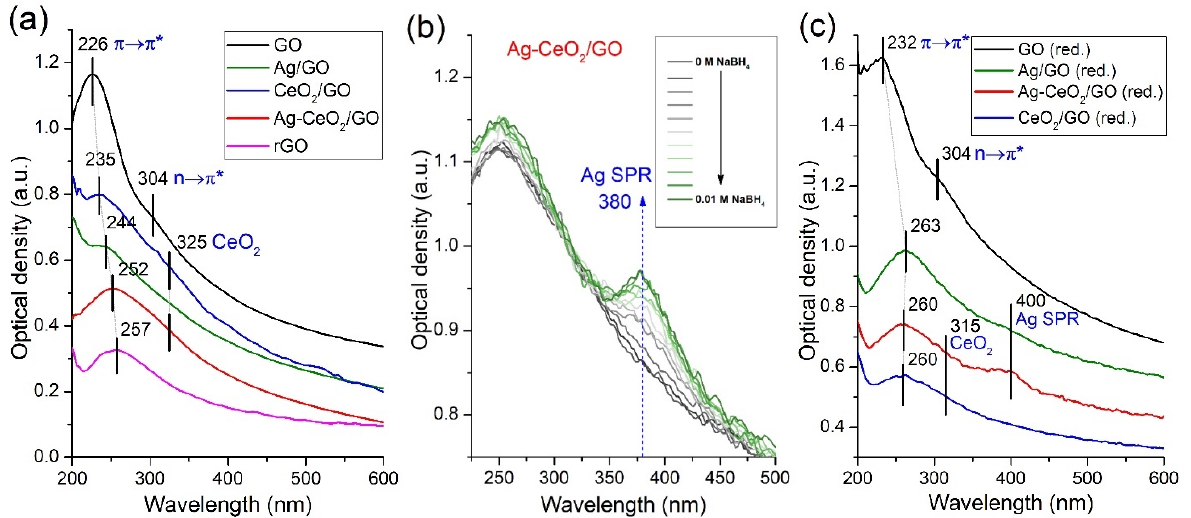
Figure 5. UV–VIS spectra of aqueous suspensions of graphene derivatives and catalysts ( C (sample) = 0.75 g/L) ( a ); absorption spectra evolution of the Ag ‐ CeO 2 /GO suspension with increasing NaBH 4 concentration ( b ); and UV–VIS spectra of aqueous suspensions of graphene derivatives and cata ‐ lysts ( C (sample) = 0.15 g/L) pre ‐ reduced in 0.01 M NaBH 4 in the presence of US for 15 min ( c